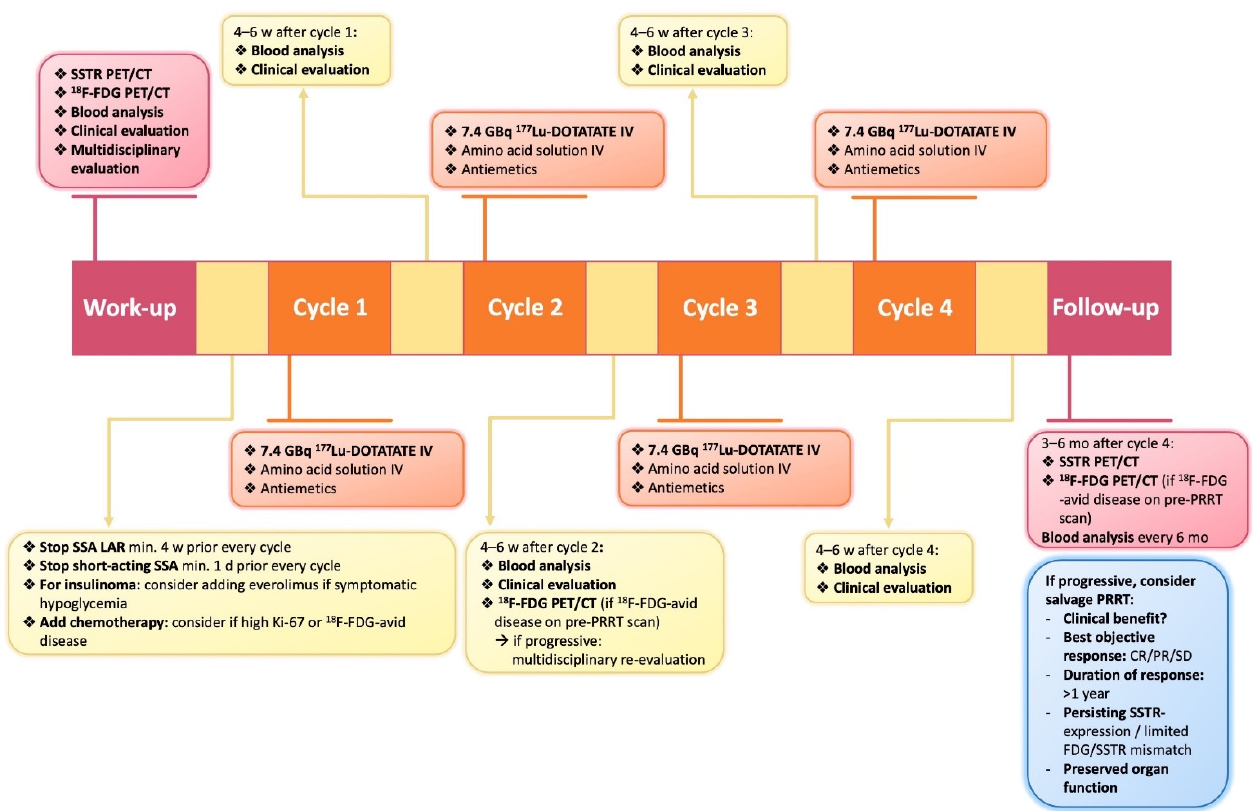
Figure 1. Proposed standardized PRRT scheme. IV = intravenous; SSA = somatostatin analogue; LAR = long-acting release; mo = months; w = weeks; d = day; PRRT = peptide receptor radionuclide therapy; CR = complete response; PR = partial response; SD = stable disease; SSTR = somatostatin receptor; FDG = fluorodeoxyglucose.